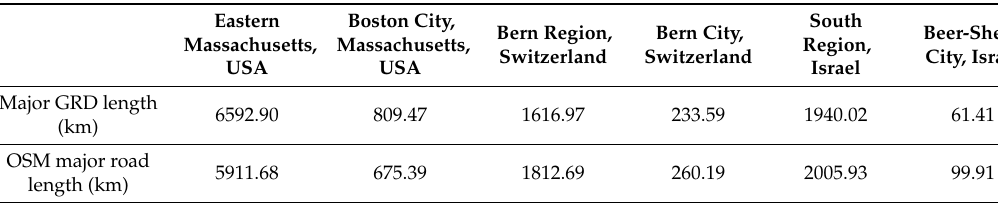
Table 3. OSM completeness.